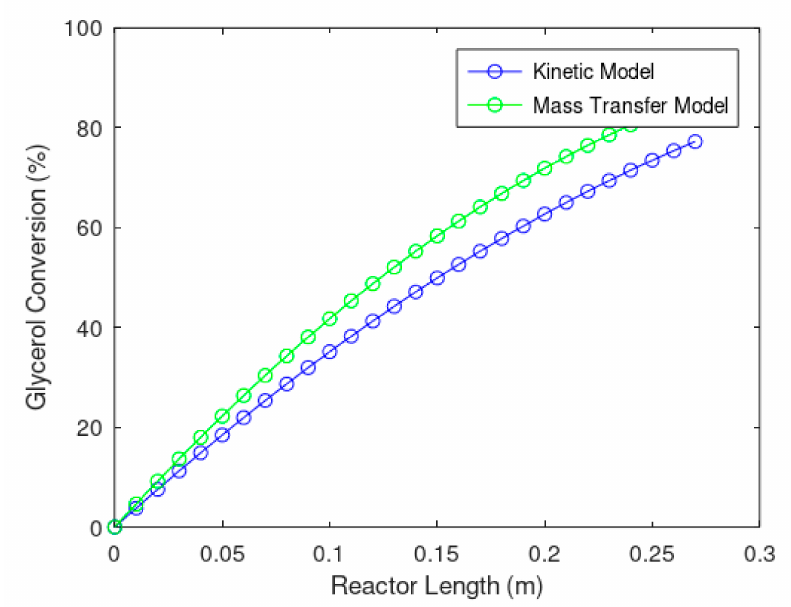
Figure 4. Conversion of glycerol through the reactor.